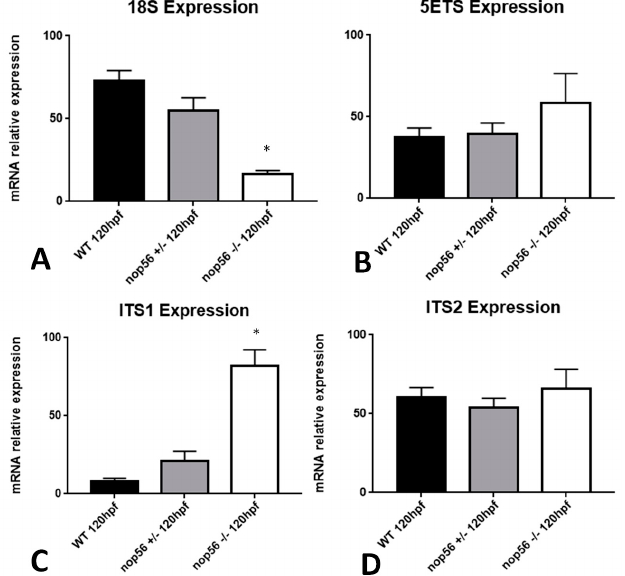
Figure 12. Graphic representation of mRNA expression analysis by RT-qPCR. ( A ) nop56 expression is significantly different in wild-type, nop56 +/ − and nop56 − / − larvae between 72 and 120 hpf ( p -value < 0.0001). ( B ) nop58 expression is significantly higher in nop56 − / − and nop56 +/ − larvae between 72 and 120 hpf ( p -value < 0.0001.) ( C ) fbl expression is significantly higher in nop56 − / − larvae between 72 and 120 hpf ( p -value < 0.0001) and in nop56 +/ − at 120 hpf respect to wild-type larvae ( p -value < 0.0001). Statistically significant data in the graphs are indicated with a *.